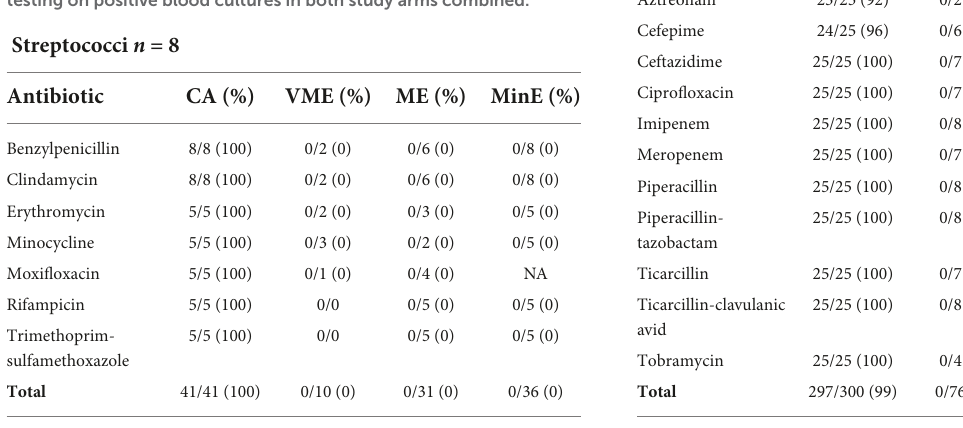
TABLE 4 Results from disk difffusion AST (filter paper disks, Bio-Rad) of 8 streptococci from a liquid colony following FAST TM System testing on positive blood cultures in both study arms combined.